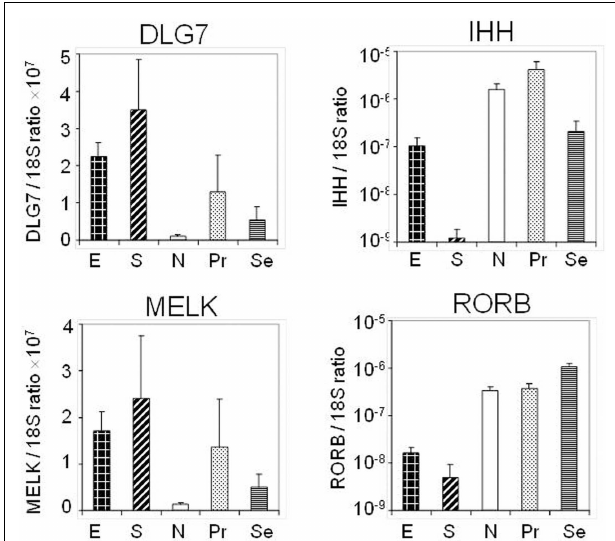
FIGURE 3 | Quantitative PCR of four selected transcripts performed on an independent set of endometrial tissues to include stage I serous (S) and endometrioid (E) cancers, normal post menopausal epithelium (N), proliferative epithelium (Pr), and secretory epithelium (Se)